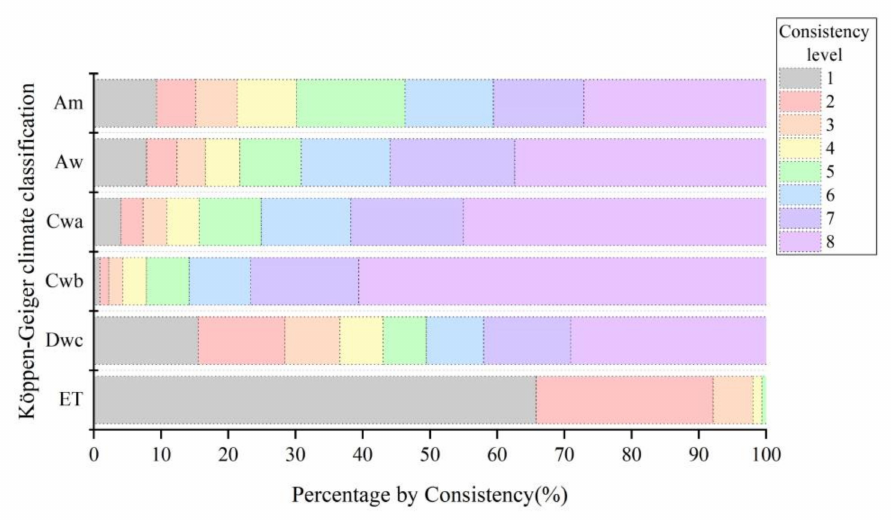
Figure 11. The proportion of eight spatial consistency levels in 6 climate